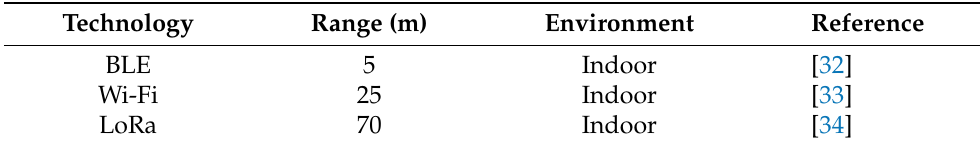
Table 6. The ranges of the communication technologies that were adopted in the use